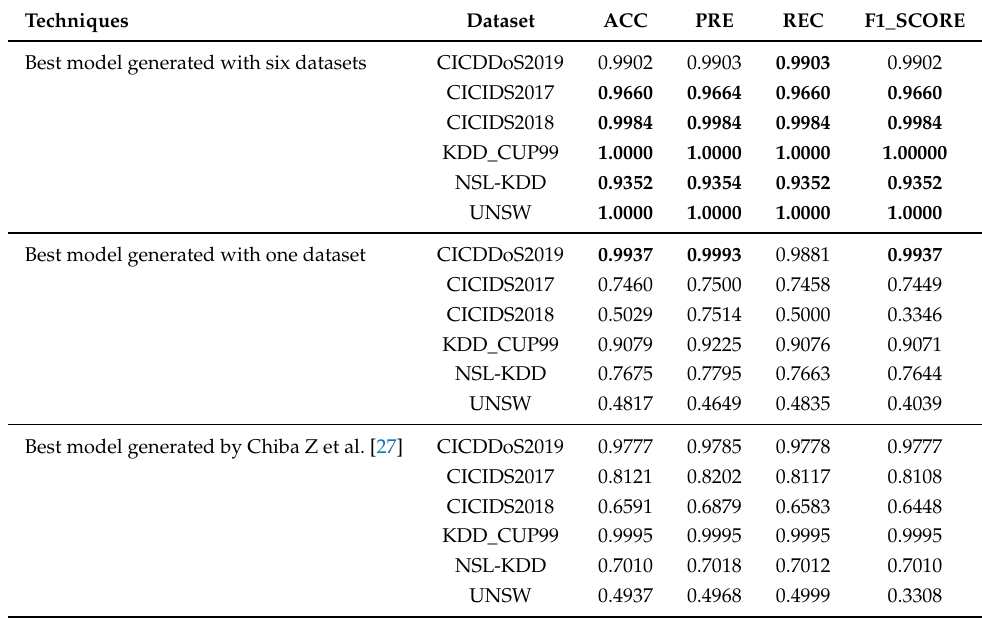
Table 14. Performance of models generated by different generation methods under different